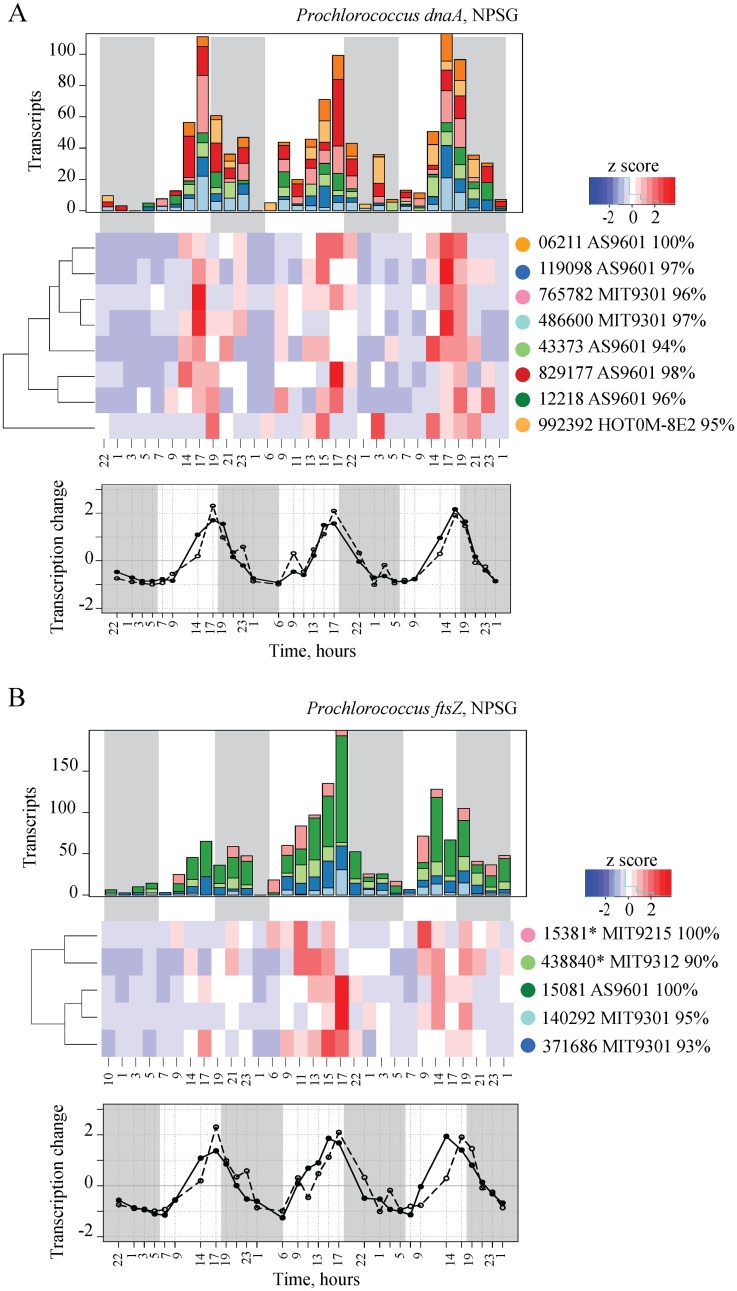
OTU-Specific Prochloroccus Daily Gene Transcription Patterns in the NPSG.Periodic transcription of the DNA replication initiation protein dnaA (A) and cell division protein ftsZ (B) genes varied among Prochlorococcus OTUs. Top panels: Transcriptional composition detected based on the MAGC approach, where transcription was normalized to the total Prochlorococcus hits in each sample, over time of day (X-axis in hours). OTUs are color-coded according to the heatmap. The transcript-OTU name (for example, 119098 AS9601 98%) shows ID of the target sequence (119098) for which probes were designed and percent nucleotide identity of the OTU to the most similar genome sequence (AS9601 98%). Transcription for all OTUs shown was estimated based on at least three probes with the exception of the two OTUs indicated with *. Middle panels: Hierarchical clustering of transcription patterns (by Pearson correlation). Each row in the heatmap shows transcription pattern of a unique OTU, and each column is a time point within the time-series. Bottom panels: Temporal patterns of total transcript abundances detected by MAGC (open circle) in this study and by WGPB (closed circle) [12] shows that the results of the two approaches are consistent.